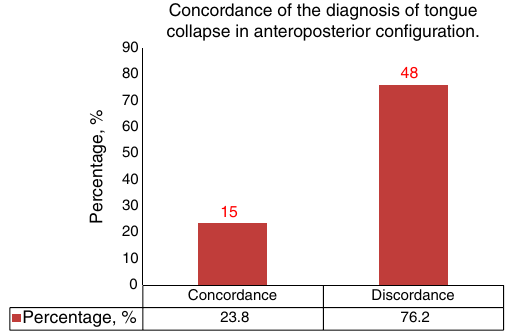
Concordance of the diagnosis of tongue collapse in anteroposterior configuration.